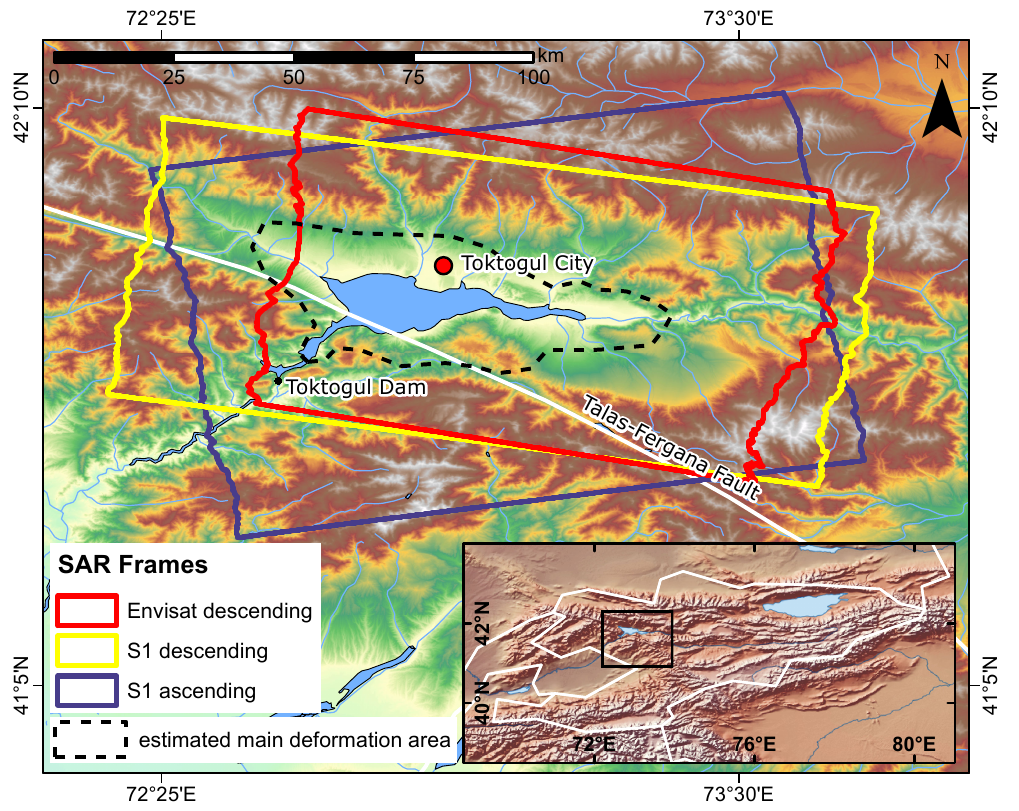
Figure 1. Location of the Toktogul Reservoir, city and dam with the outlines of the cut SAR data frames that are used for the final analysis. The alignment of the Talas-Fergana Fault is based on vector data from the Kyrgyzstan Disaster Risk Data Platform [15]. The dashed outline denotes the estimated area of the main deformation. The inset shows the location of the area within